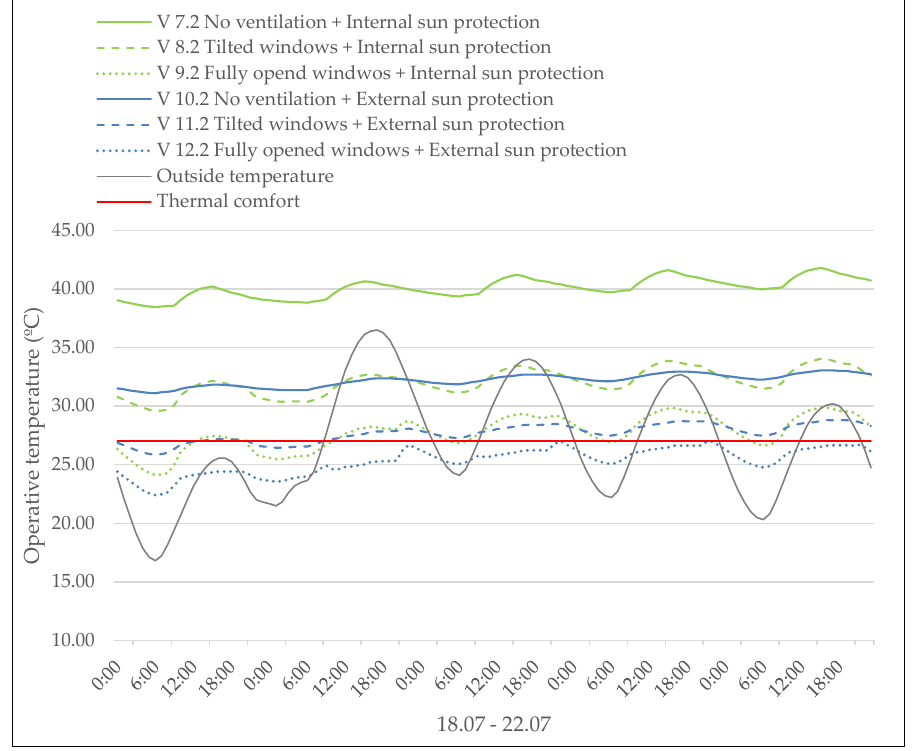
Figure 7. Future climate scenario — Variants of sun protection and night ventilation, based on [33].